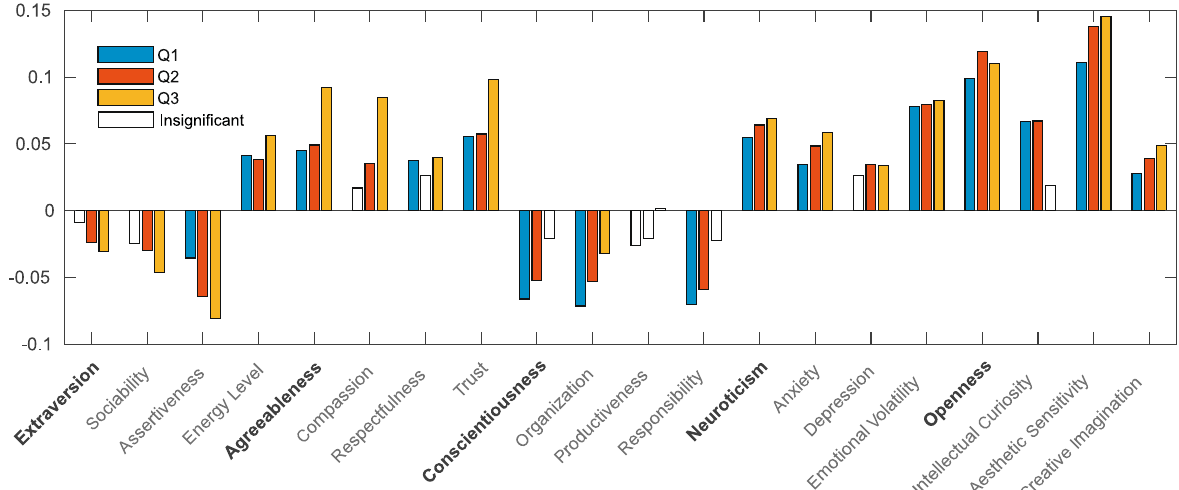
Fig. 2 Pearson’s correlation coefficients, describing correlations between three rating types and personality domains. The Big Five main traits are marked in bold. Statistically insignificant correlations ( p > 0.05 ) are marked in white